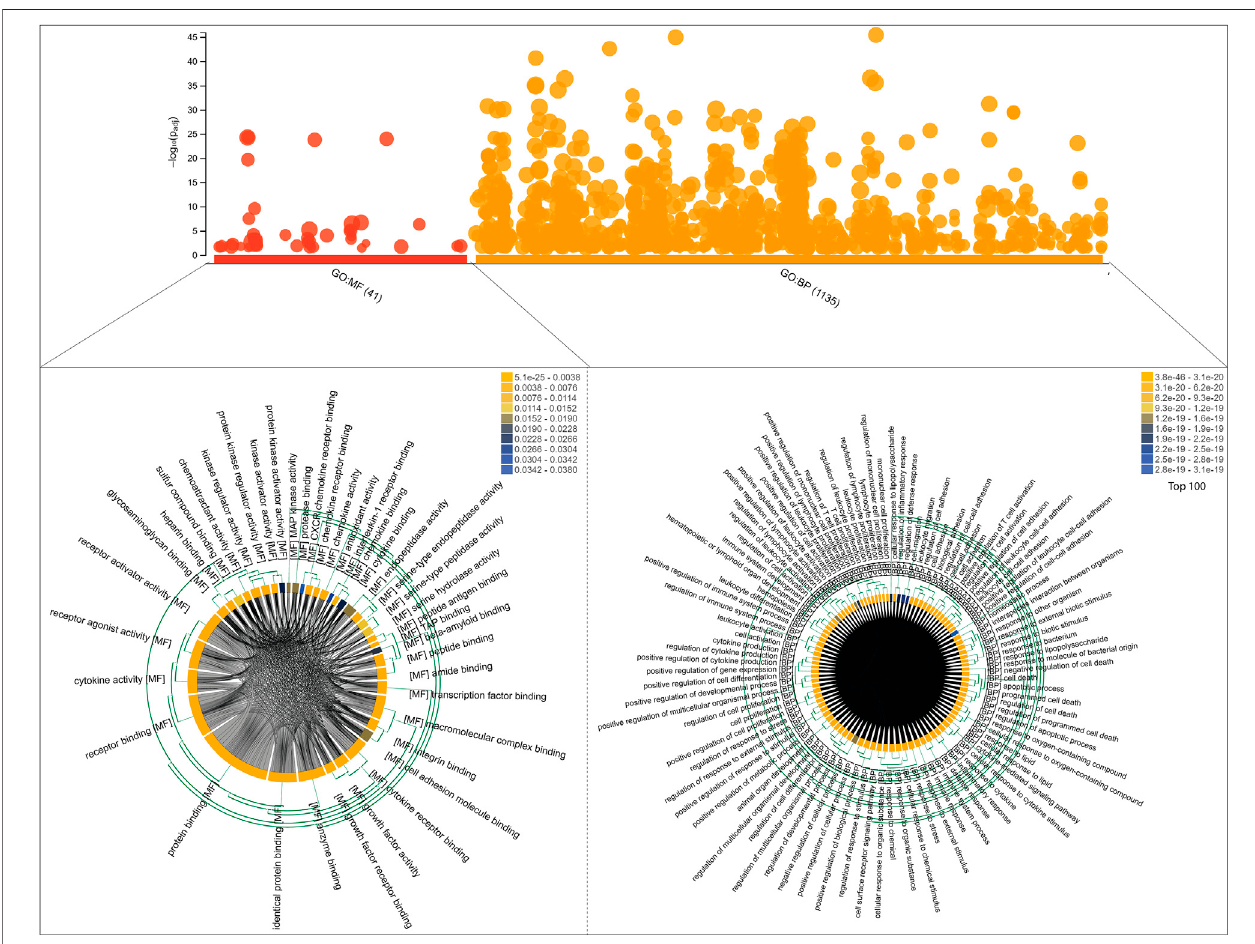
FIGURE 6 | Functional enrichment analysis of 86 target genes, including molecular functions and biological processes, is shown on the bubble graph based on log10(P adj ) values in the Y axis. The clustering of Gene Ontology (molecular functions and biological processes) is shown in chord diagrams for target genes.